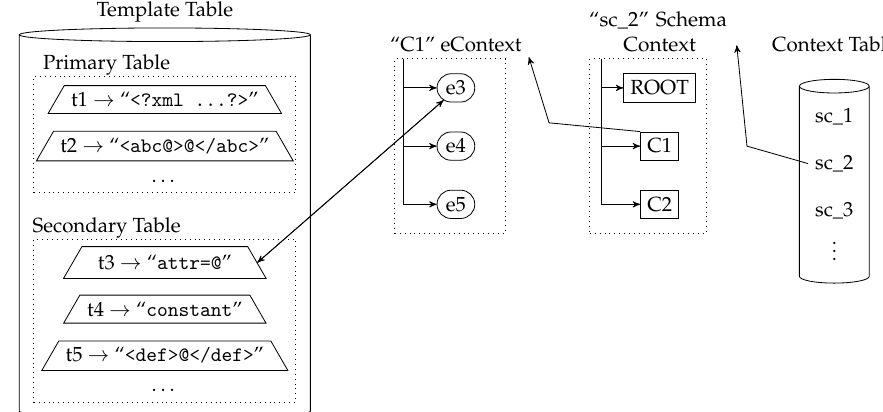
Figure 4. Template Table structure